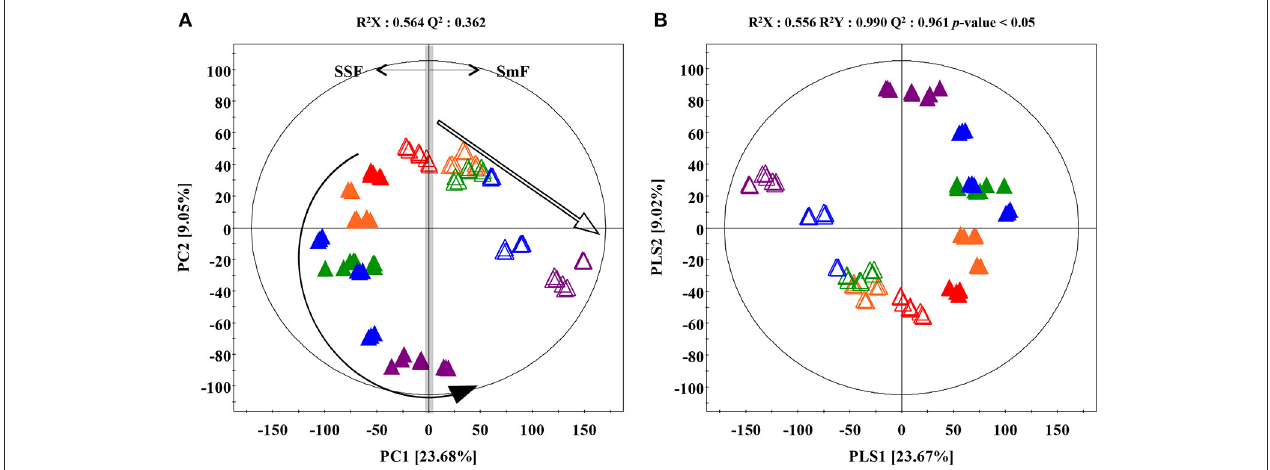
FIGURE 1 | (A) Principal component analysis (PCA) and (B) partial least squares-discriminant analysis (PLS-DA) score plot derived from the UHPLC-LTQ-IT-MS/MS datasets for A. oryzae KCCM 12698 during SSF and SmF conditions. The arrow indicate the flow of times changes. ( , Solid-state fermentation; , Submerged fermentation; , 0 day; , 4 days; , 8 days; , 12 days; , 16